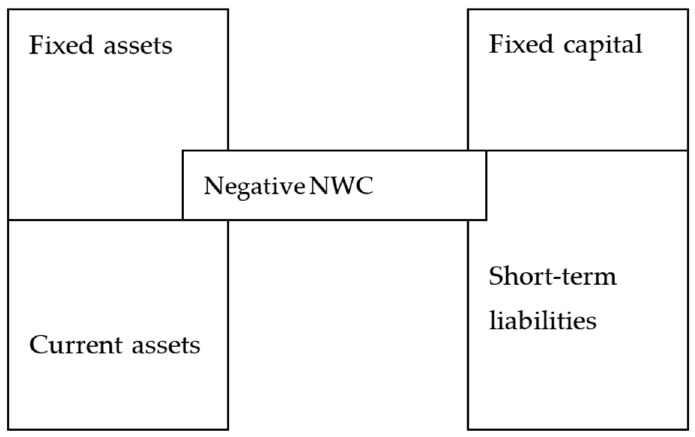
Figure 4. Negative net working capital. Source: own research. Working capital is equal to zero occurs when current assets equal short-term liabili- ties, as shown in Figure 5.